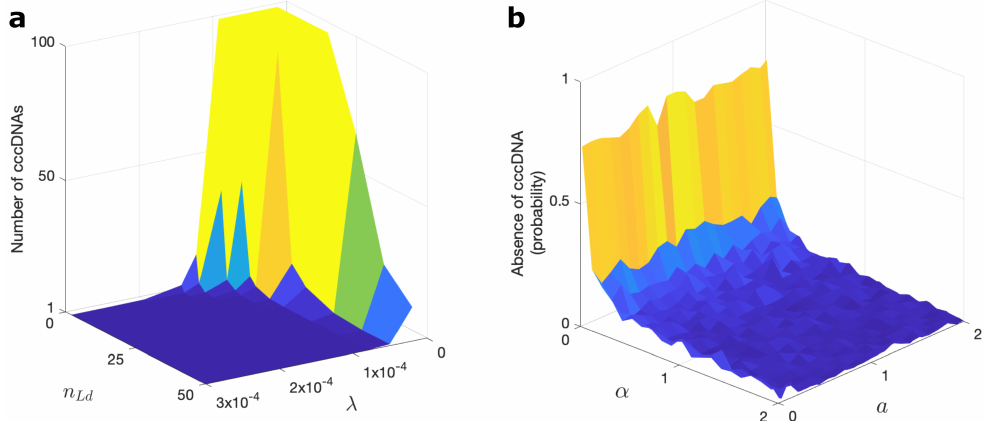
Figure 4. Prediction of cccDNA amplification and revealing rcDNA delivery step as the most crucial reaction in cccDNA formation. ( a ) The average number of cccDNAs in an infected cell as a function of λ and n Ld (Supplementary Equations (S1) and (S3)). The increase in the number of cccDNAs happens due to the intracellular cccDNA amplification step (Step 8; Figure 1). ( b ) The probability of prevention of cccDNA formation over 10,000 simulations after viral entry in a drug-free case. We just consider the cccDNA formation step (Step 1; Figure 1) when one rcNC is entered into a cell. Probability indicates the number of simulations where cccDNA did not get formed over 10,000. This figure is plotted using parameter values from Supplementary Table